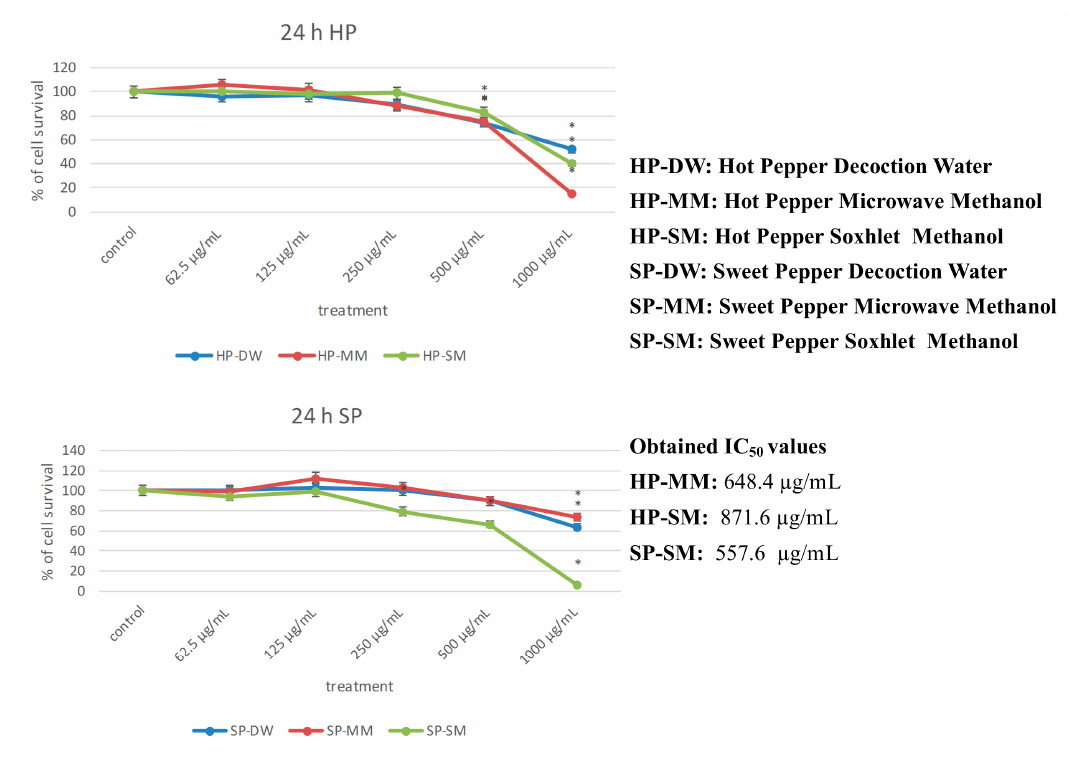
Figure 4. Inhibition values of cell growth with hot and sweet pepper extracts (* p < 0.05).